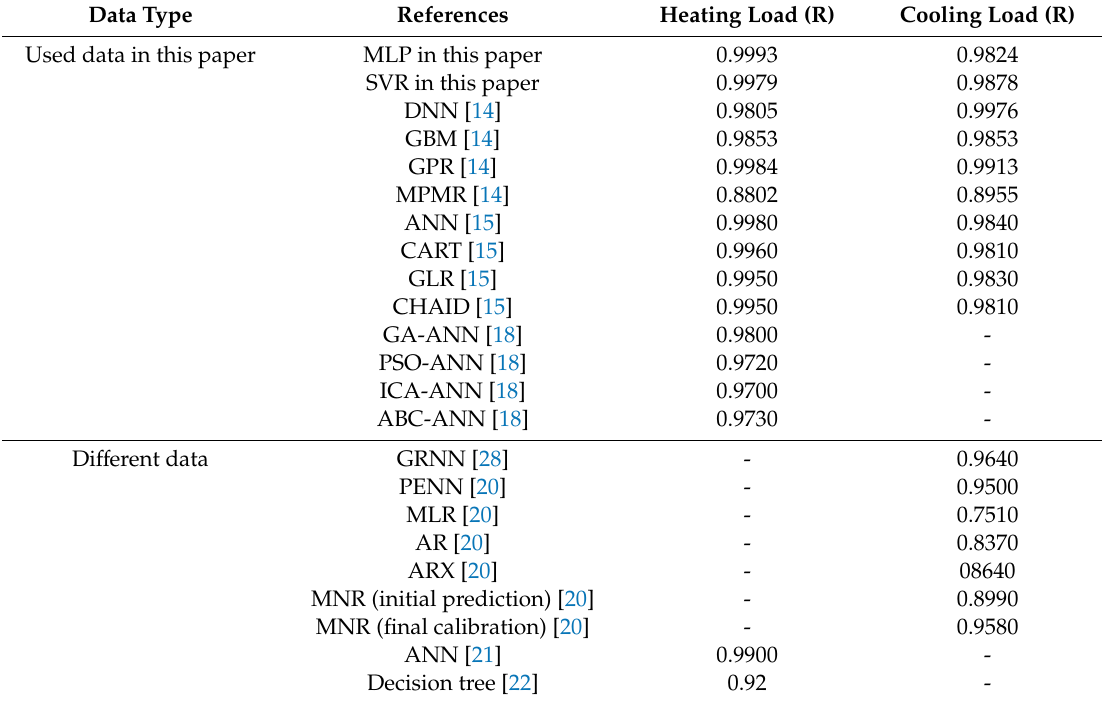
Table 3. Comparison of cooling and heating loads prediction results with other